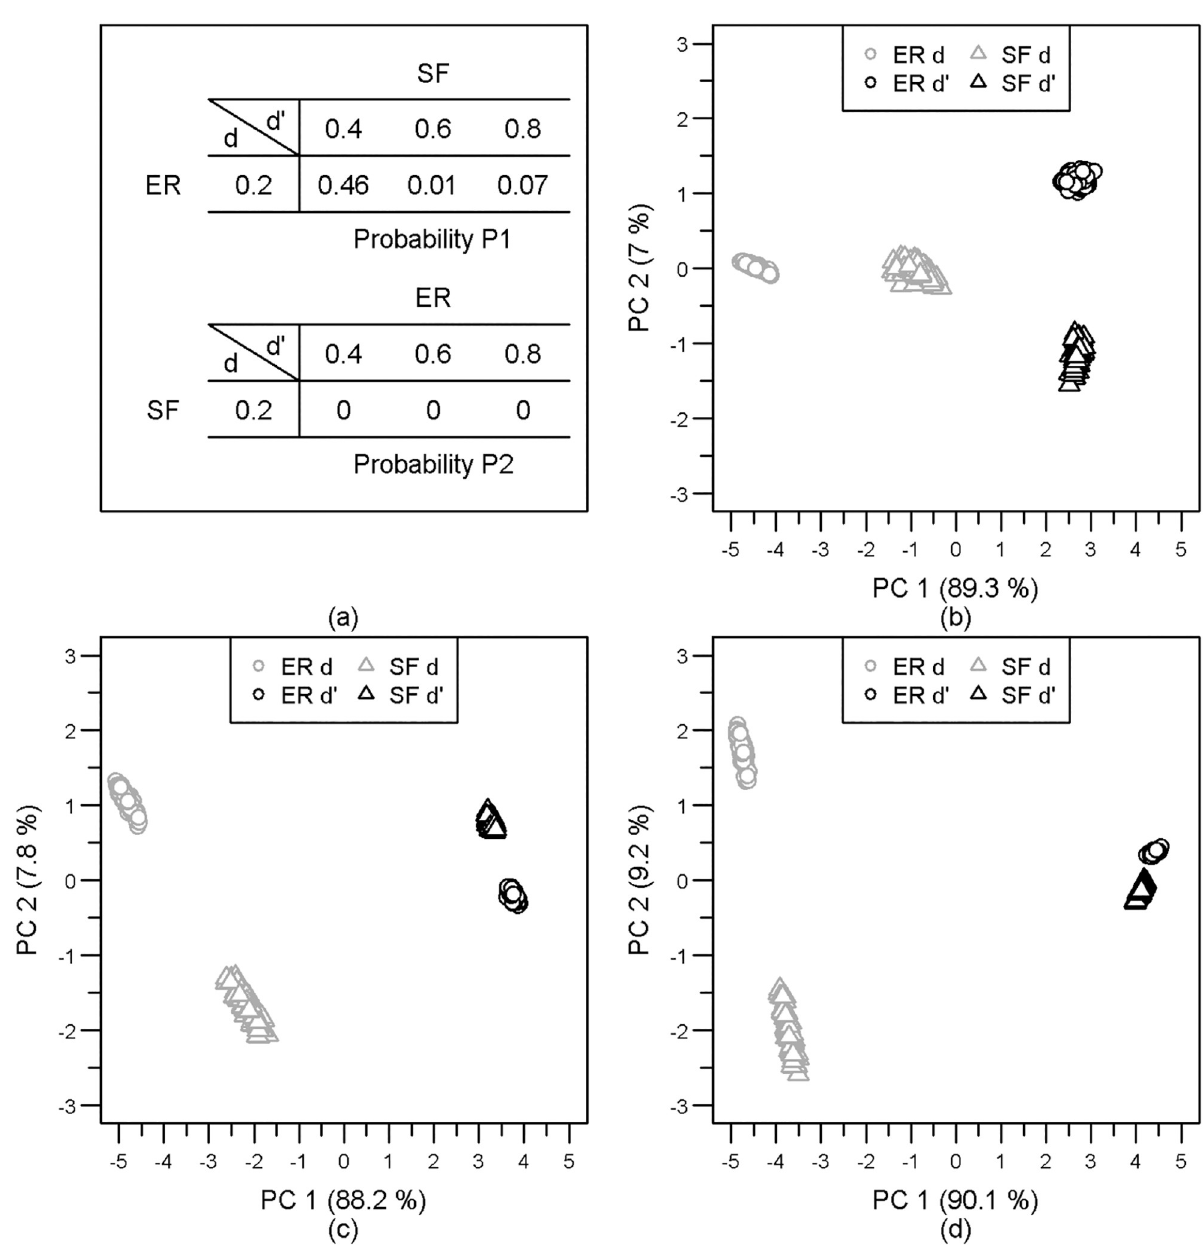
Fig 4. PCA between Erd ő s-Re´nyi and Fitness Scale-Free graphs of order N = 100 and different edge density. (b) ( d = 0.2, d 0 = 0.4), (c) ( d = 0.2, d 0 = 0.6), (d) ( d = 0.2 d 0 = 0.8). For each density, 100 graphs of each model are projected according to their 55 graphlet correlation coefficients (upper or lower triangle of the GCM ). (a) The two probabilities P associated with each comparison in the matrix of probability B are respectively P 1 for B ER , SF ER (100, d ), SF (100, d 0 ) and P 2 for B ER (100, d 0 ), SF (100, d ) . With increasing edge density differences (b),(c) and (d) the two groups of dense graphs gradually become more and more similar. components explain at least 96% of the input variability (Fig 4). There are two orthogonal lin- ear combinations of the graphlet correlation coefficients that represent the same amount of information as the 55 coefficients. Given that the 2D space of the two principal components contains nearly 100% of the initial variability, the euclidean distance in this 2D space is a